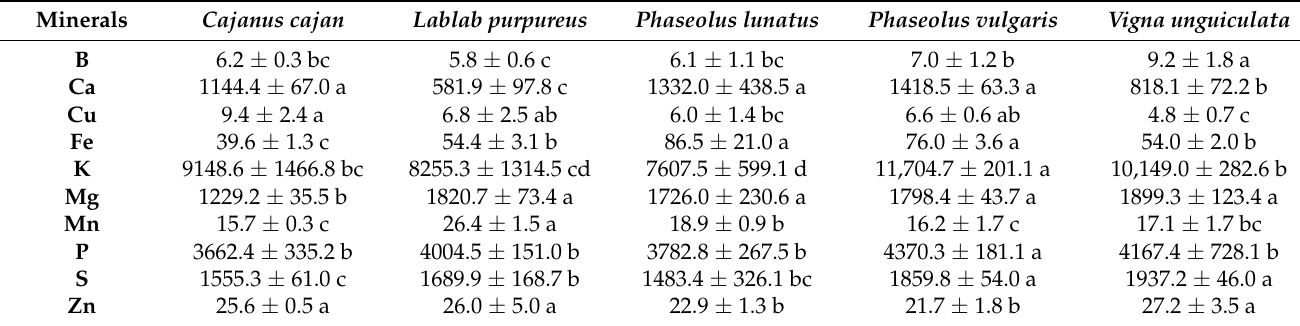
Gallic acid equivalents. 3 AAE, Ascorbic acid equivalents.